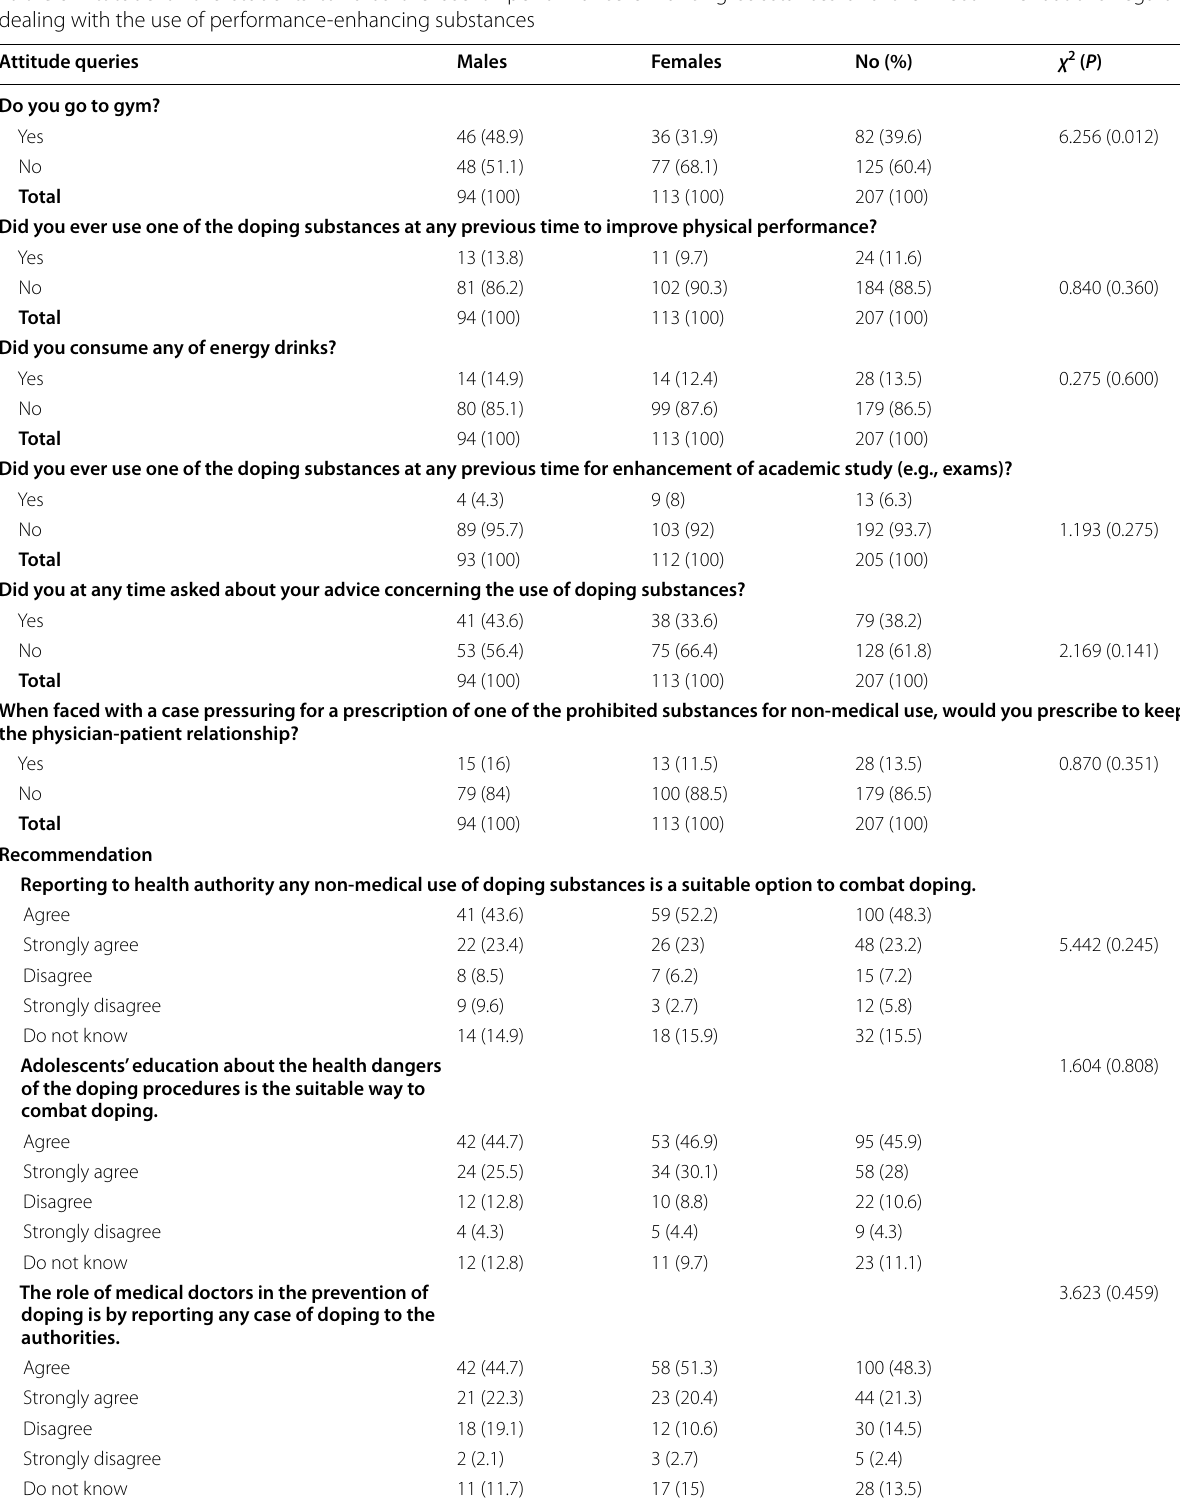
Table 6 Attitude of the students towards the use of performance-enhancing substances and their recommendations